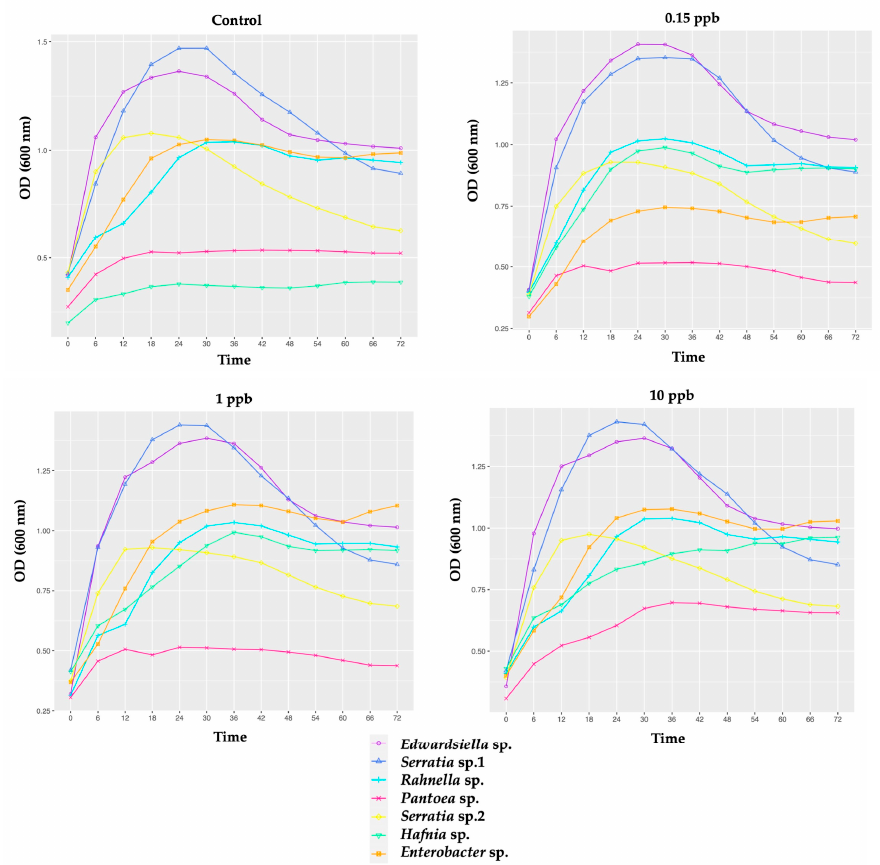
Figure 2. The bacterial growth curves represent the optical density (OD) units at 600 nm over time (hours). In order (from left to right, up to down), for Edwardsiella sp., Serratia sp.1, Rahnella sp., Pantoea sp., Serratia sp.2, Hafnia sp. and Enterobacter sp. cultured in TSB liquid media supplemented with 0 ppb (Control-first graph), 0.15 ppb (second graph), 1 ppb (third graph) and 10 ppb (fourth graph) for 72 h. The experiment was performed in triplicate. Each data point represents the average optical density (600 nm) measured every 6 h. Multiple comparisons using an ANOVA analysis were computed. p -values were adjusted with Tukey’s method (See Supplementary Material Table S2).